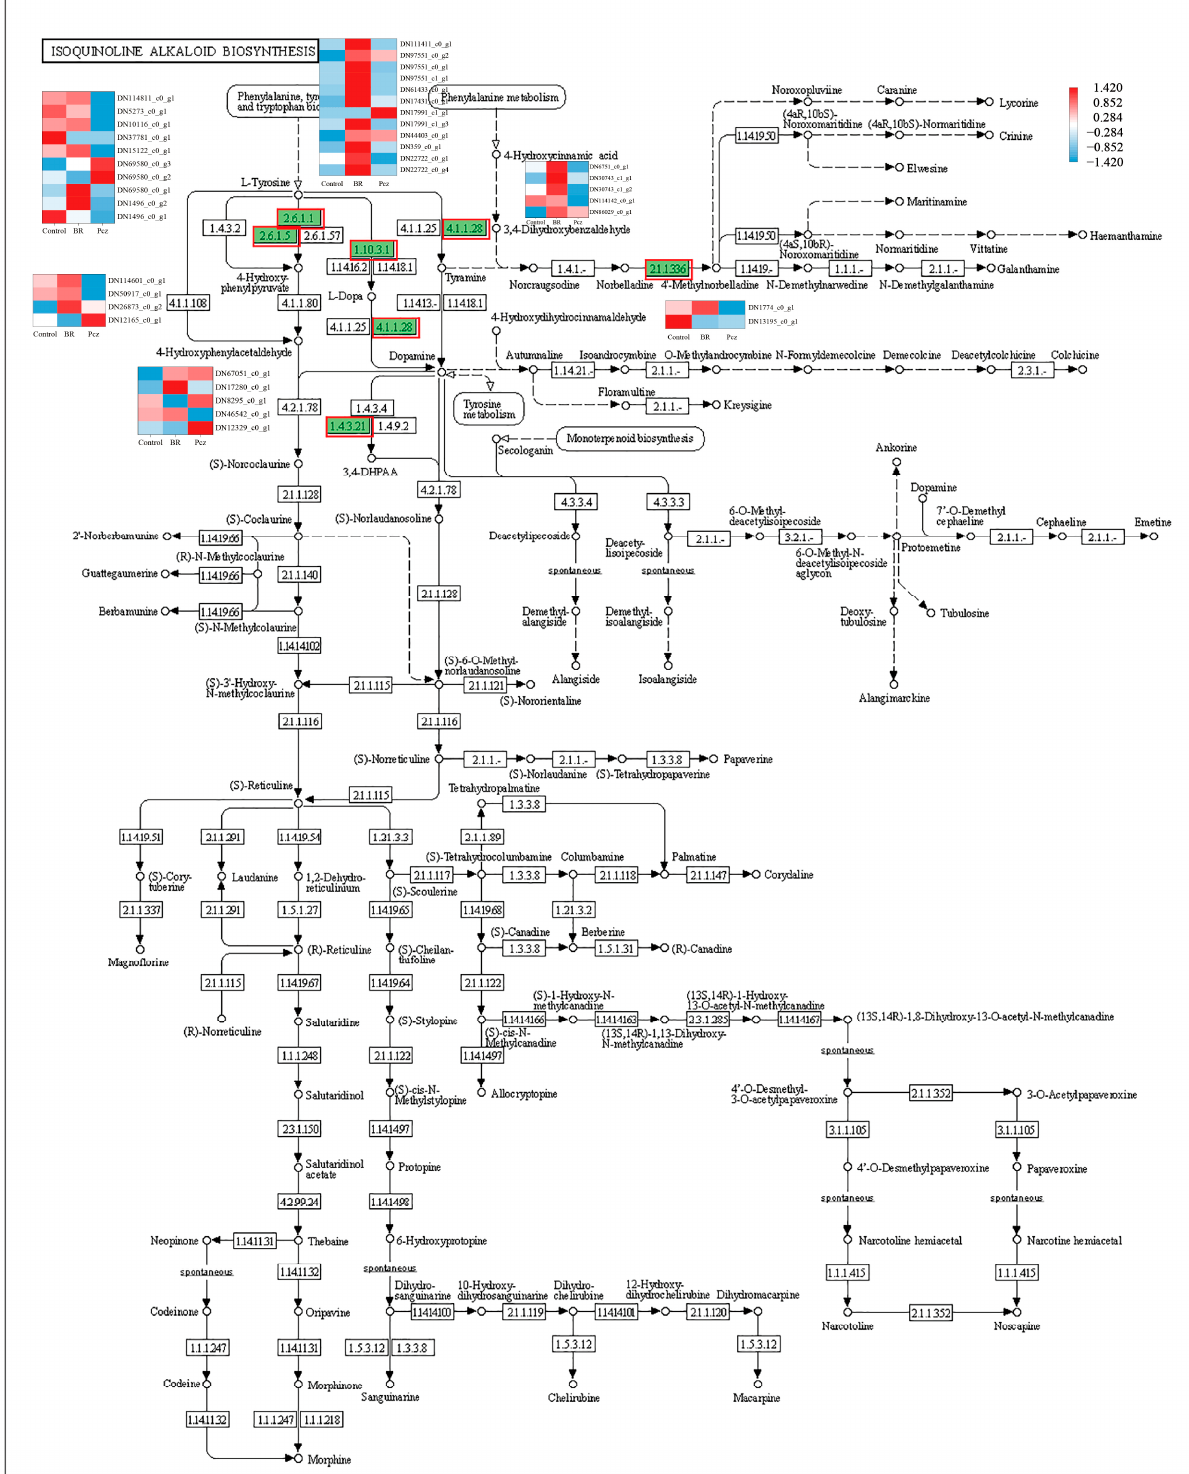
Figure 6. Differential expression levels of unigenes related to isoquinoline alkaloid biosynthesis identified by KEGG annotation. Changes in expression level are represented by a change in color; blue indicates a lower expression level, whereas red indicates a higher expression level. All data shown reflect the average mean of three biological replicates.